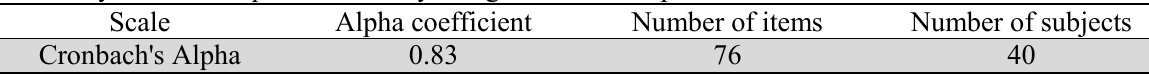
Reliability of the first questionnaire by using Cronbach's alpha method Scale Alpha coefficient Number of items Number of subjects